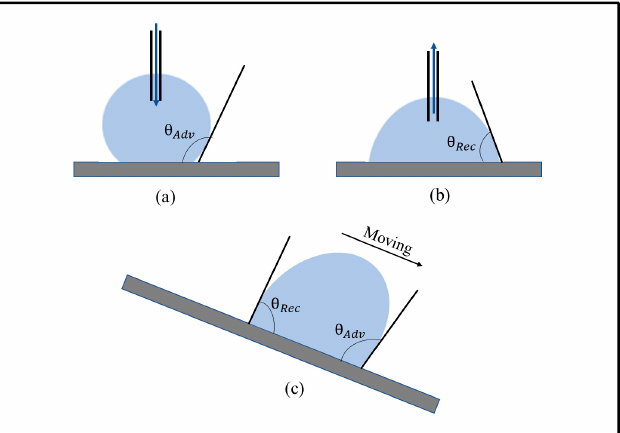
Figure 5. ( a , b ) Schematics of the sessile droplet method to measure contact angle hysteresis (CAH) and ( c ) a schematic of advancing and receding contact angles on the tilting plate. ( c ) a schematic of advancing and receding contact angles on the tilting